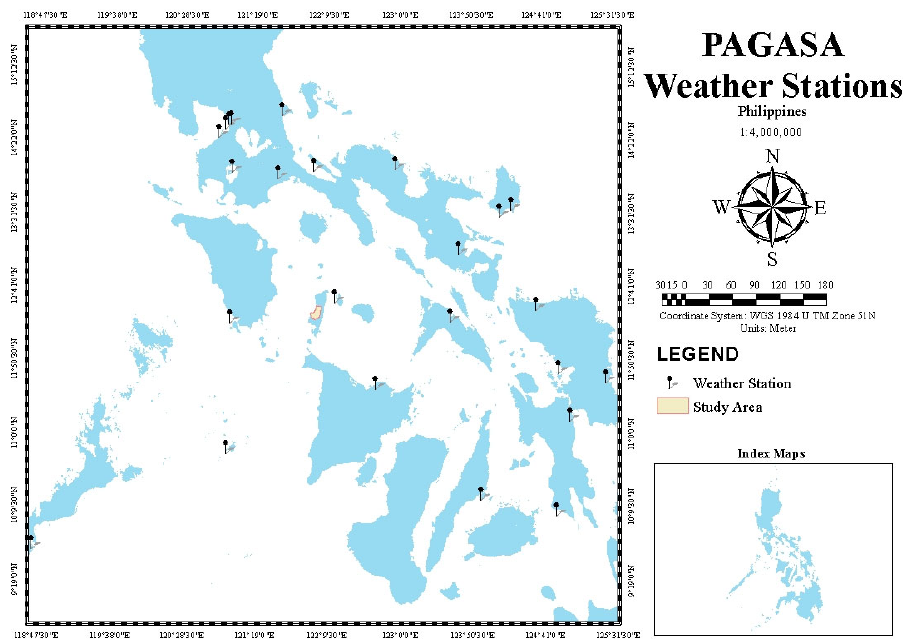
Figure 2. Weather stations considered in the interpolation for average annual rainfall using the Isohyetal Method.